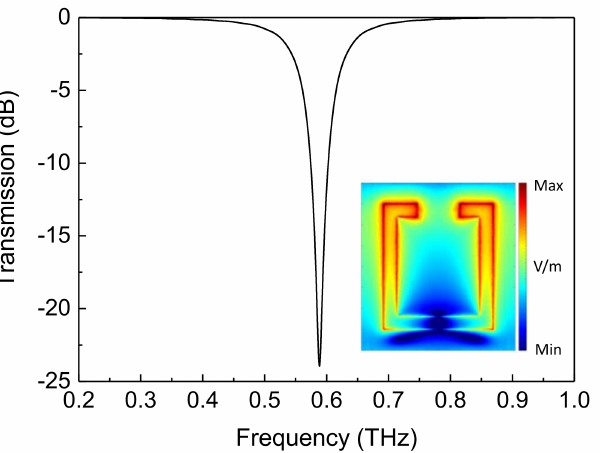
Figure 4. Simulated spectrum of polyimide-coated metamaterials. The insert presents the near-field distribution of the PET substrate with the simulated polyimide-coated SRR at 0.588